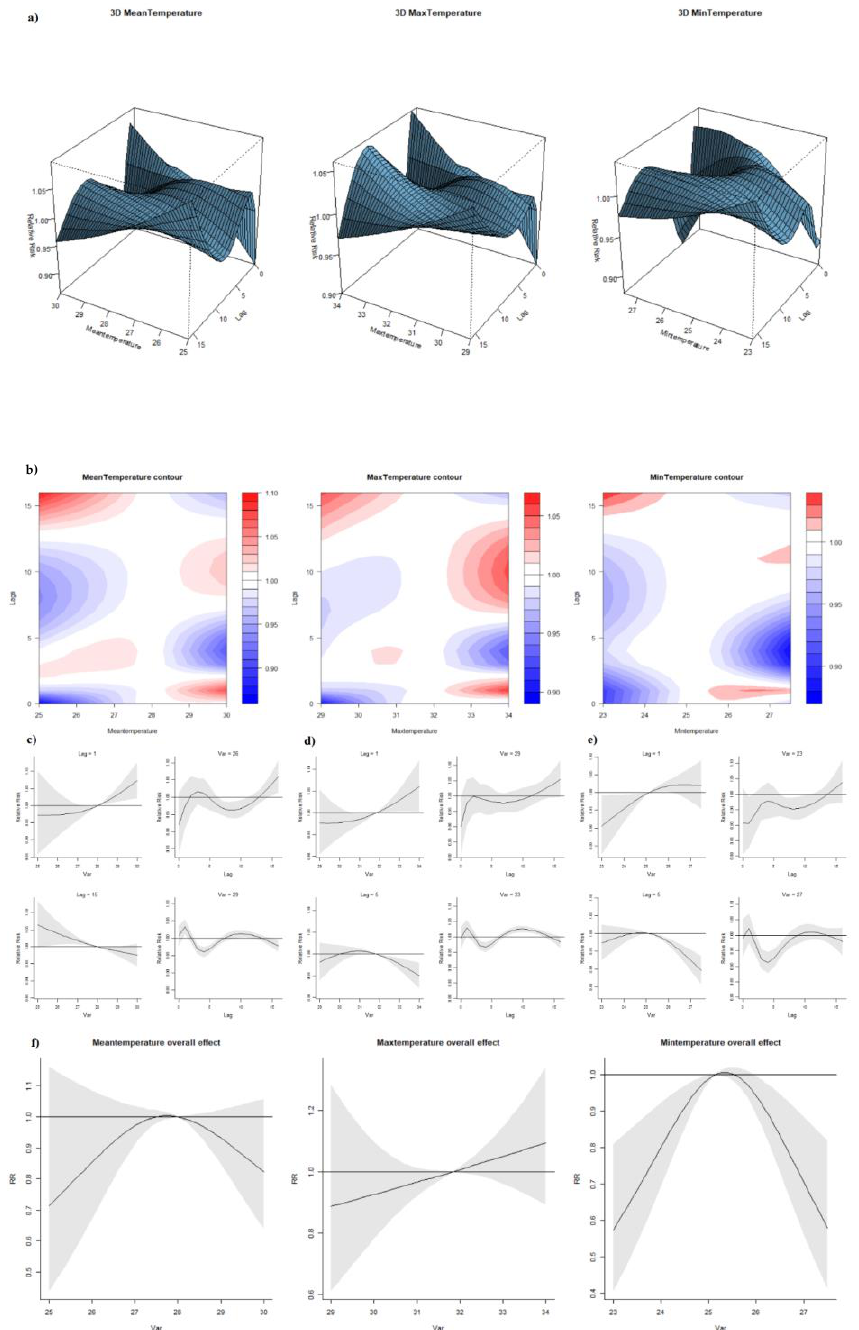
Figure 5. ( a ) 3D graph of temperature-lag-dengue association; ( b ) contour graph of temperature- lag-dengue association; ( c ) sliced graph of mean temperature/lag-dengue association (notes: left top panel shows temperature-dengue association at lag 1 while left bottom one at lag 5; right top panel shows lag-dengue association at mean temperature 26 ◦ C while right bottom one at mean temperature 29 ◦ C; ( d ) sliced graph of max temperature/lag-dengue association (Notes: left top panel shows max temperature-dengue association at lag 1 while left bottom one at lag 5; right top panel shows lag-dengue association at max temperature 29 ◦ C while right bottom one at max temperature 33 ◦ C); ( e ) sliced graph of min temperature/lag-dengue association (Notes: left top panel shows min temperature-dengue association at lag 1 while left bottom one at lag 5; right top panel shows lag-dengue association at min temperature 23 ◦ C while right bottom one at min temperature 27 ◦ C); ( f ) overall effect graph of mean temperature-dengue